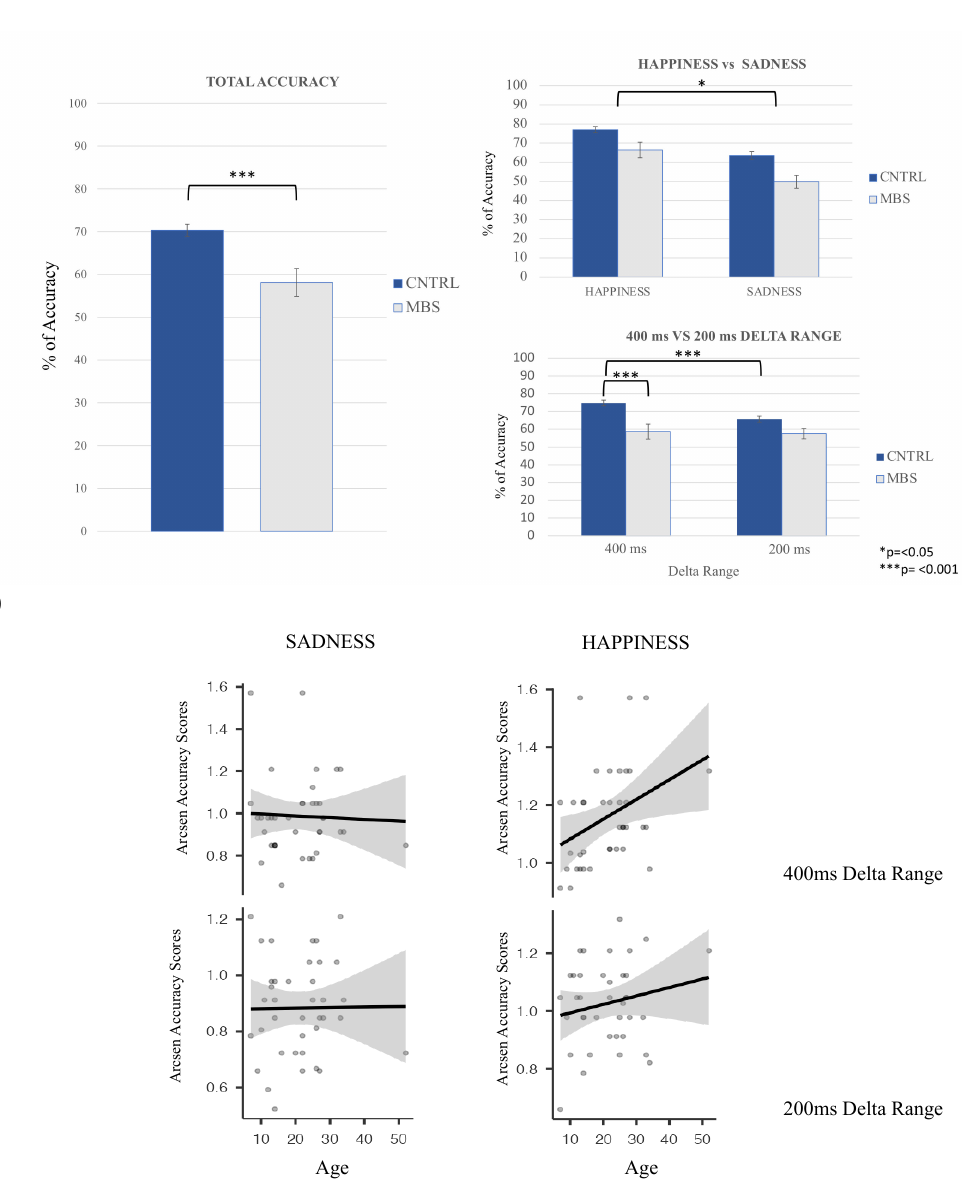
Figure 3. ( a ) The main effect of group for total accuracy (mean percentage of total accuracy for MBS and control participants). The left panel illustrates the main effect of emotion condition (upper part), in which both MBS and control participants demonstrated higher accuracy in terms of correctly recognizing the duration of happy facial expressions, and the group by delta range interaction (lower part), with controls performing better than MBS patients for the delta range representing the greatest difference (400 ms). ( b ) The correlation matrix for the correlational analysis performed with control participants between arcsin transformed accuracy scores for sadness and happiness at both 200 ms and 400 ms delta ranges, as a function of age. The analysis revealed no significant correlation, with the corrected p -value set at